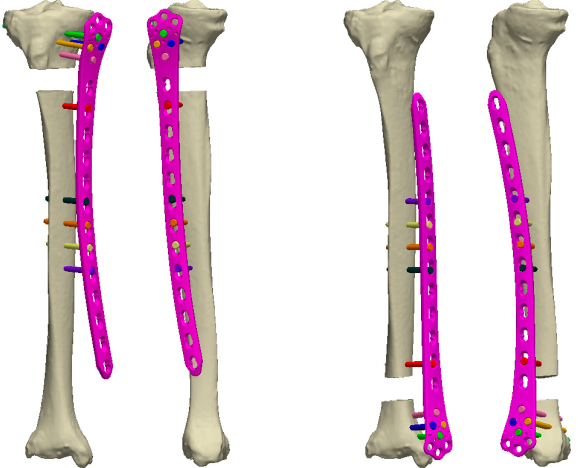
Figure 5. Anterior and medial views of bone-plate constructs with an unstable, meta-diaphyseal, either proximal ( left images) or distal ( right images) tibial fracture, mimicked via osteotomizing a 20 mm gap and fixed with a plate elevation of 22 mm representing externalized locked plating with 20 mm soft tissue thickness.